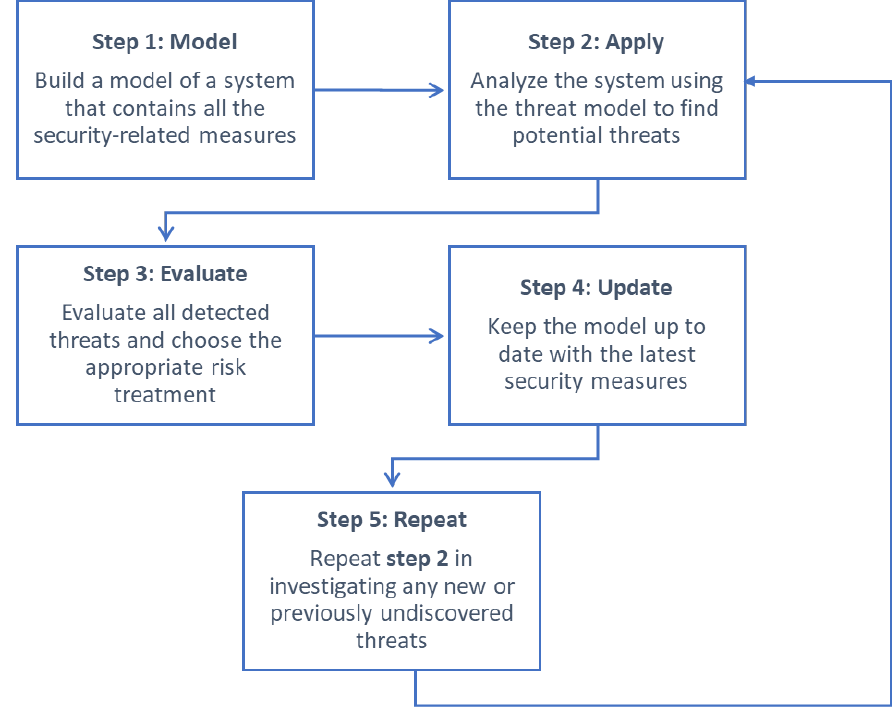
Figure 4. Main steps of the threat modeling